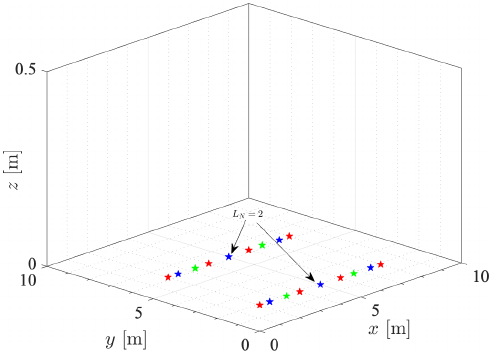
Figure 2. Map of different LED transmitter scenarios deployed in the seabed following a grid structure. Green, blue and red stars refer to L N = [ 4,6,8 ] , respectively. The case of L N = 2 overlaps with two LEDs of the ( L N = 6 ) LED configuration.